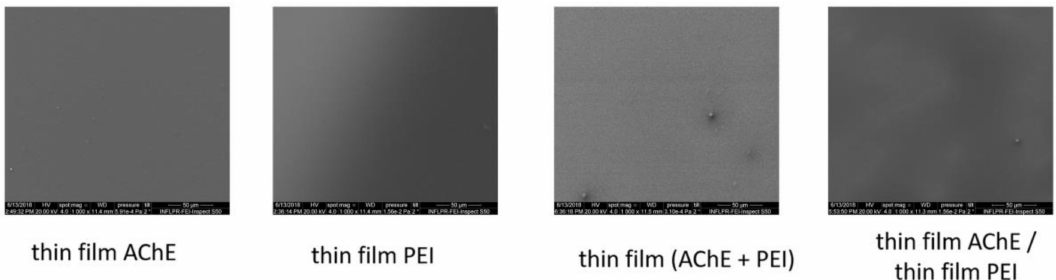
Figure 3. Top-view SEM of the MAPLE samples obtained on Si. Scale bar: 50 µ